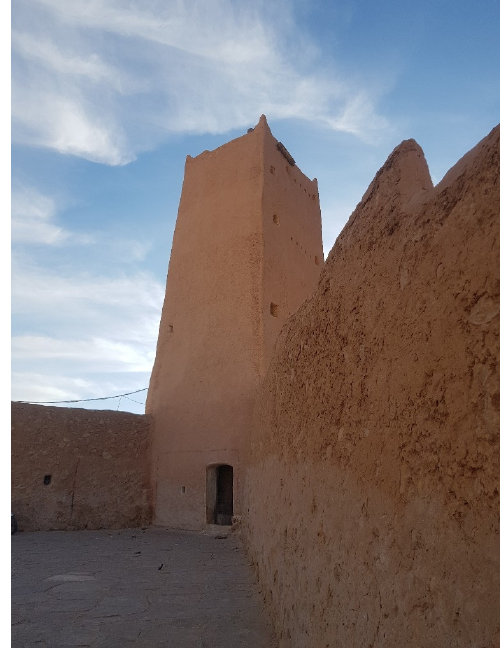
Figure 1. An example of earthen construction (Courtesy; E. Ghorbel,